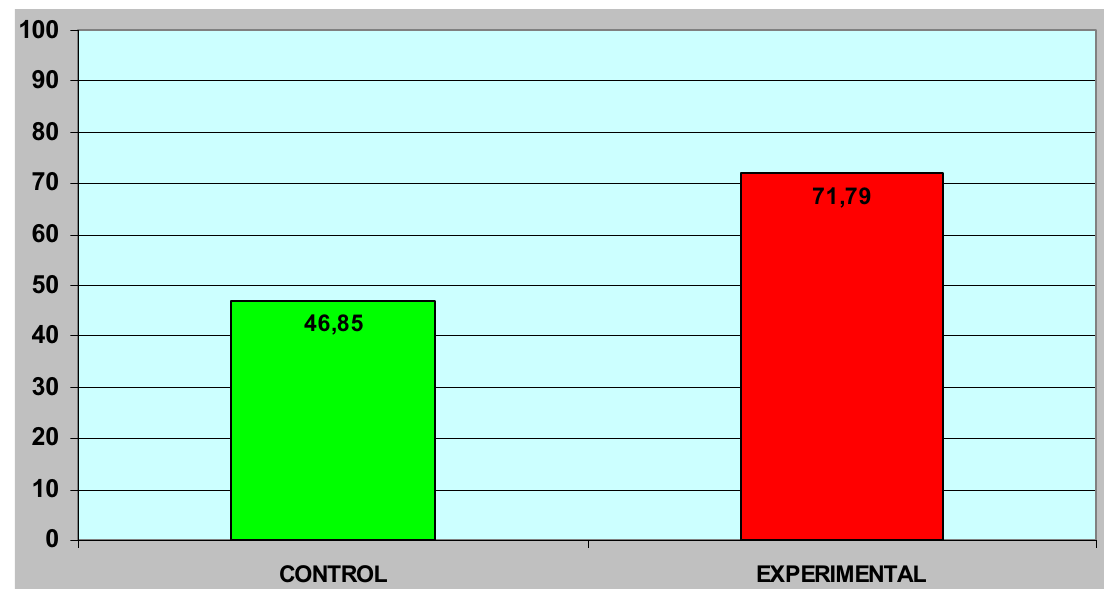
FIGURE 2 - Medium values of percentage (%) of necrosis found in Control (saline) and Experimental (nicotine)